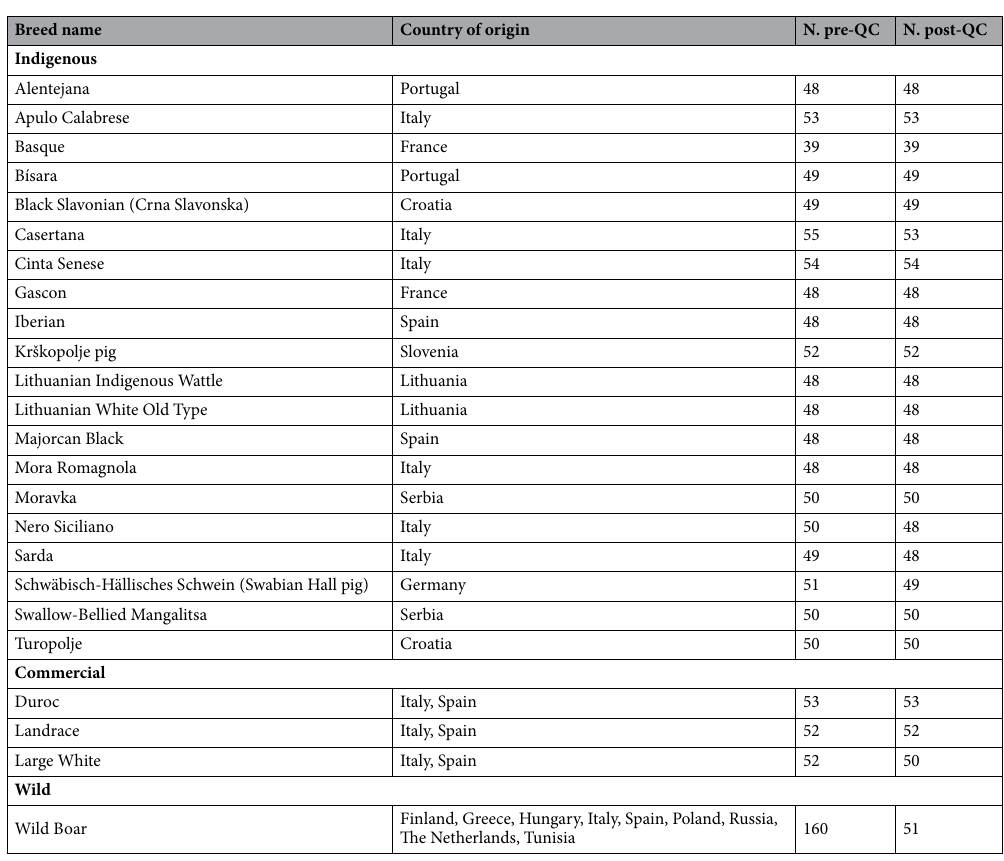
Table 1. Breed name, type, country of origin and number of pigs analysed before (pre-) and after (post-) quality control (QC) per